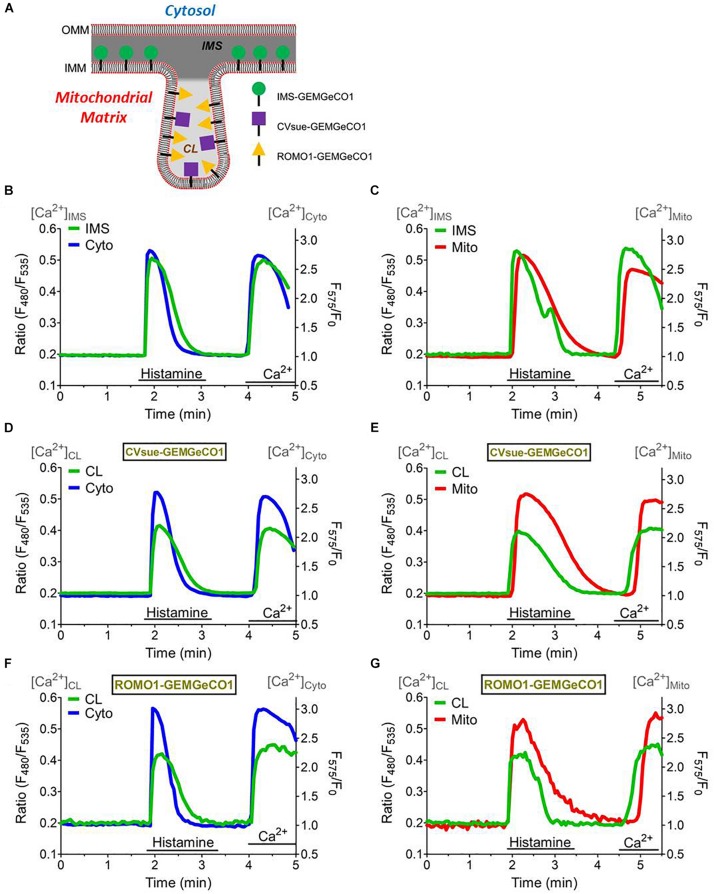
Simultaneous measurements of the sub-mitochondrial Ca2+ sensors with the cytosol and mitochondrial matrix. (A) Scheme representing targeting of MICU11– 140-GEMGeCO1, CVsue-GEMGeCO1, and ROMO1-GEMGeCO1 Ca2+ indicators within specific sub-mitochondrial regions. Dark gray region indicates intermembrane space (IMS) and light gray area the cristae lumen (CL). Simultaneous Ca2+ imaging of MICU11– 140-GEMGeCO1 (B,C), CVsue-GEMGeCO1 (D,E) and ROMO1-GEMGeCO1 (F,G) (green curves) with either CARGeCO1 (blue curve; B,D,F) or mt-CARGeCO1 (red curve; (C,E,G) co-expressing single HeLa cells treated with 100 μM histamine in the absence of extracellular Ca2+ and upon subsequent store-operated Ca2+ entry. Simultaneous measurements allow kinetical comparisons of the Ca2+ signals in the various (sub-)compartments.